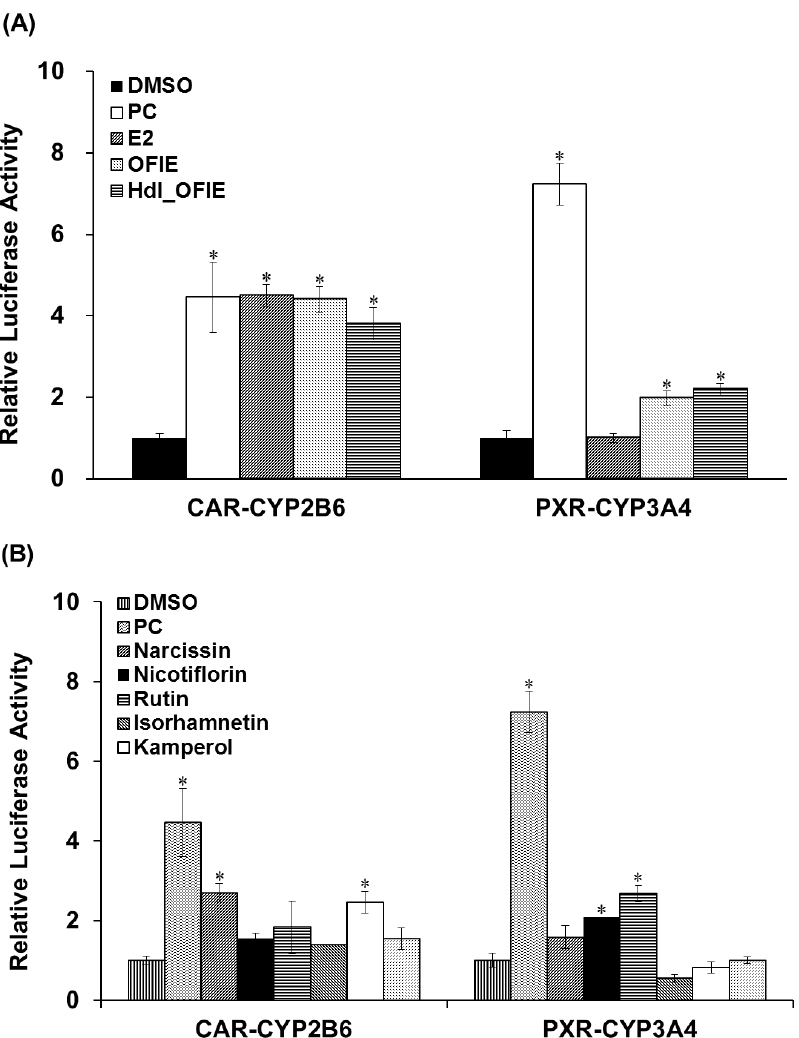
Figure 4. The transactivation of constitutive androstane receptor (CAR)-mediated CYP2B6 ( A ) and pregnane X receptor (PXR)-mediated CYP3A4 ( B ) promoter luciferase genes in HepG2 cells by Opuntia ficus indica fruit extract (OFIE) and its hydrolyzed product (A); and individual flavonoids (B). DMSO, dimethylsulfoxide (0.01%); PC, positive control, i.e., CITCO (500 nM) for CAR-CYP2B6 or rifampin (1 µ M) for PXR-CYP3A4; OFIE, Opuntia ficus indica fruit extract (OFIE, 500 µ g/mL), enzymatically hydrolyzed OFIE (Hdl OFIE, 500 µ g/mL), and individual flavonoids (10 µ M). Differences in the relative luciferase activities in various treatment groups versus that in the DMSO-treated group were determined with ANOVA followed by a Bonferroni-Dunn test. Differences in results among data sets were considered statistically significant when p < 0.001 indicated as an